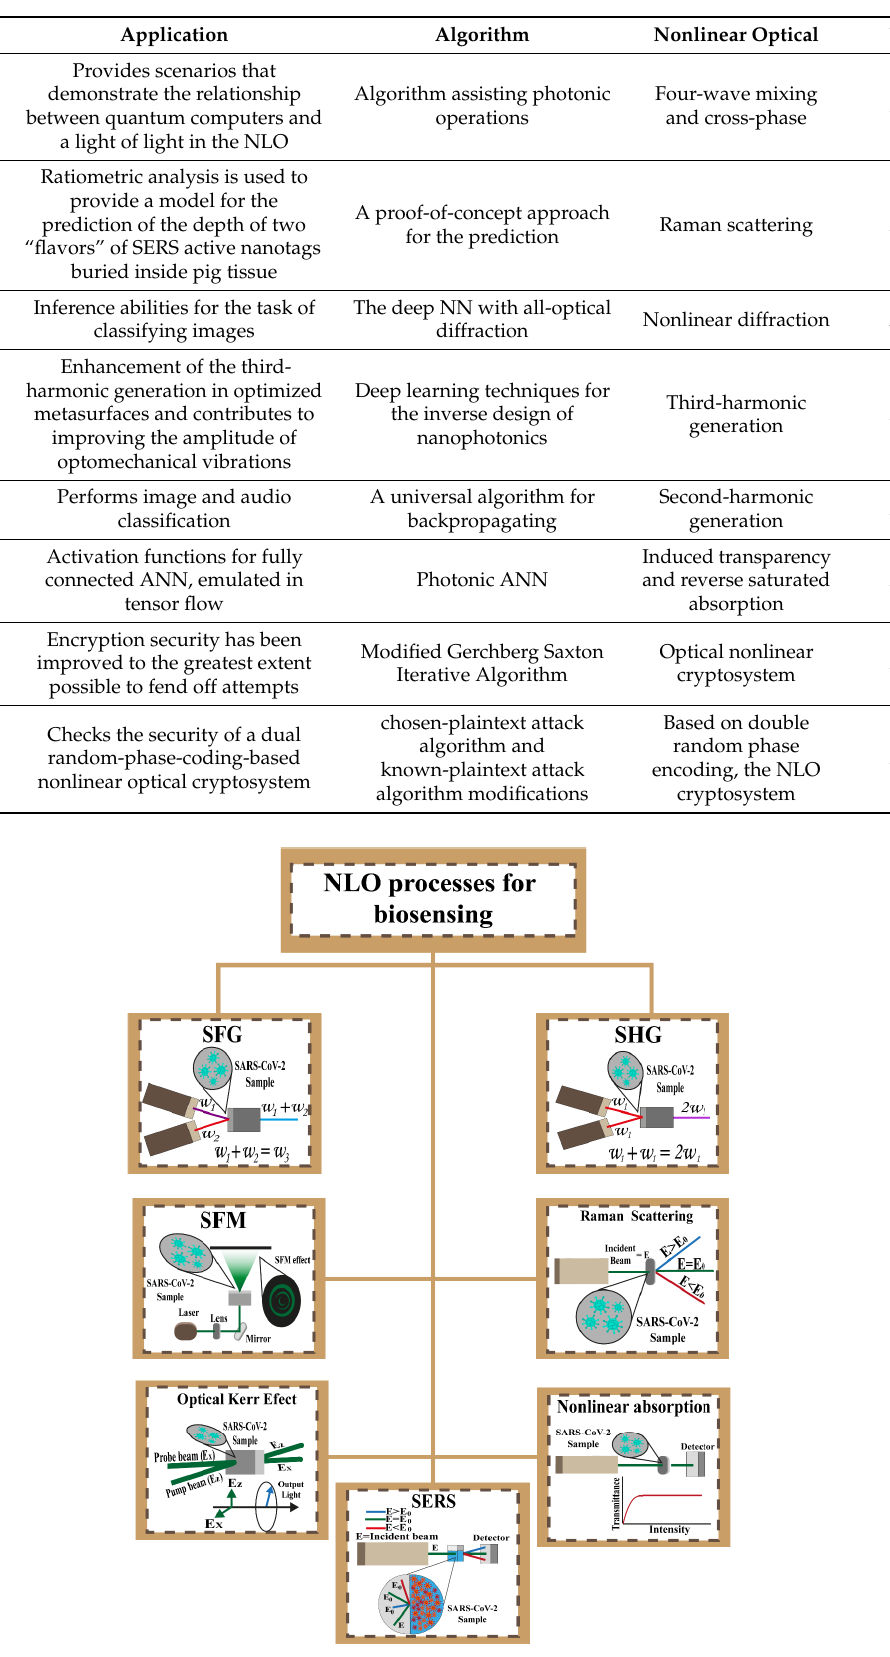
Figure 5. NLO effect schemes proposed for biosensing.